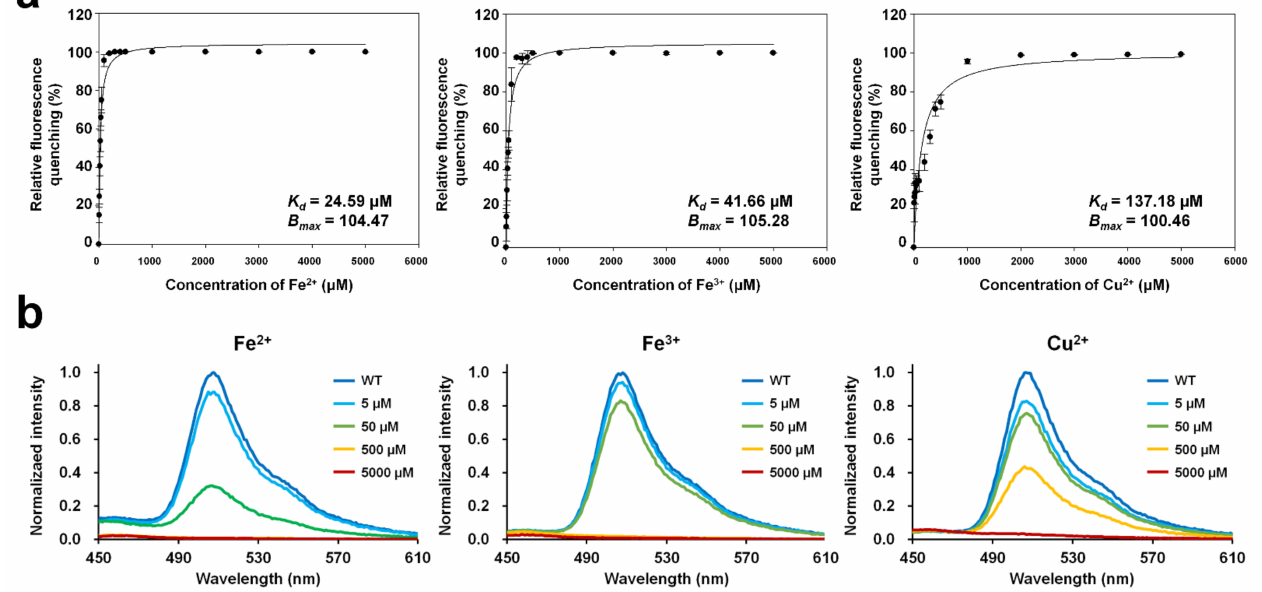
Figure 3. Metal titration of quenchable DendFP and fluorescence emission spectra in the presence of metal ions. ( a ) DendFP was titrated with various concentrations of Fe 2+ , Fe 3+ , and Cu 2+ (0 to 1 mM, resulting in final concentrations of 0 to 5000 µ M). The data fitting was performed with the one metal-binding mode by the Langmuir equation using SigmaPlot. Data represent means ± standard deviations of five replicates. ( b ) The fluorescence emission spectra of DendFP in the presence of Fe 2+ , Fe 3+ , or Cu 2+ at different concentrations (0 to 5000 µ